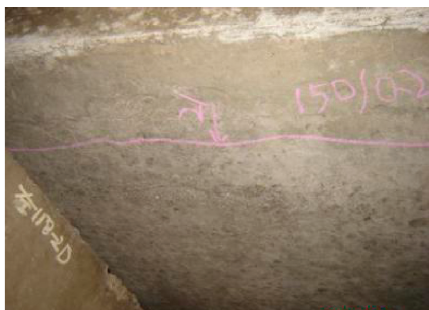
Figure 3: Longitudinal horizontal cracks in the bottom